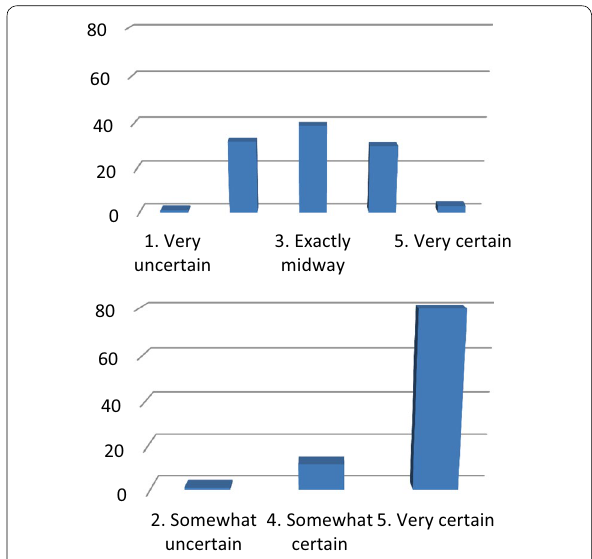
Fig. 2 Distribution of level of confidence on the formulated differen- tial diagnosis before the result of the ultrasound scan and after